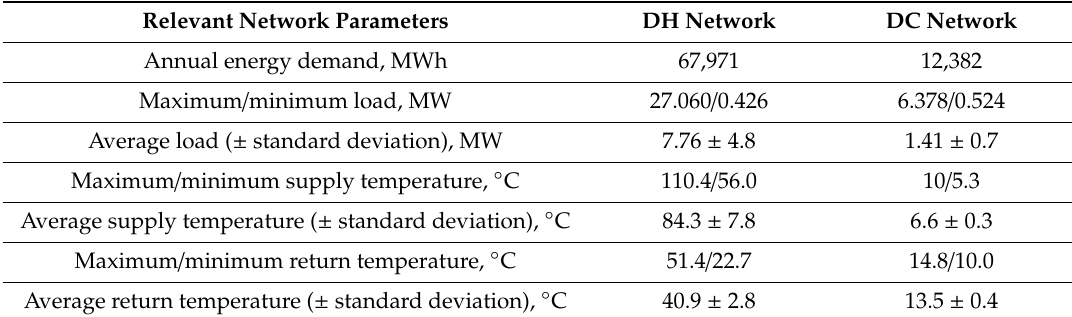
Table 1. Relevant DH–DC network parameters of Kupittaa district in Turku.